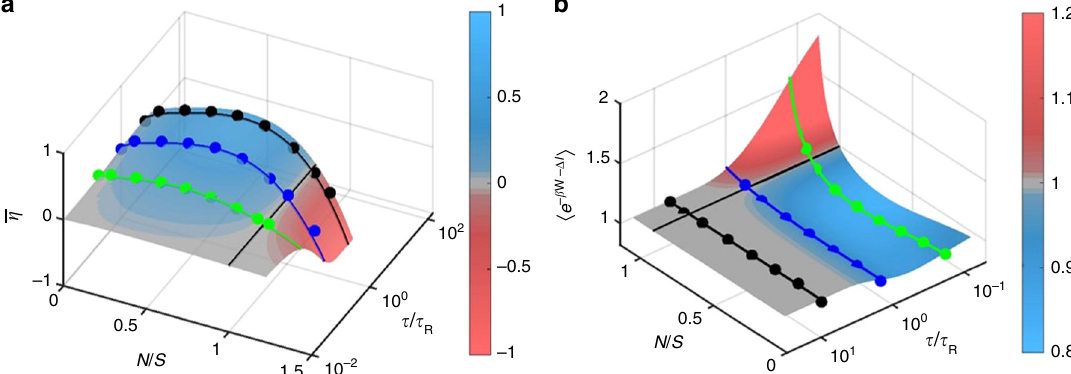
Fig. 4 Measurement of engine ef fi ciency and test of the generalized integral fl uctuation theorem. a The information utilization ef fi ciency, (cid:1) η (cid:4) (cid:3) β W h i = I h i , as a function of N /S and τ / τ (cid:1) η for τ = 20 (black circles), 3 (blue) and 0.5 (green) ms. The solid R . Solid circles are experimentally obtained curves are plot of the model (the ratio of Eqs. (2) and (4)). b Contour plot of 〈 exp( − β W – Δ I ) 〉 as a function of N/ S and τ / τ R using Eq. (6). The solid circles are the experimental plot of 〈 exp( − β W – Δ I ) 〉 as a function of N/ S for τ = 20 (black circles), 3 (blue circles), and 0.5 (green circles) ms. The solid curves are obtained by plotting Eq. (6).